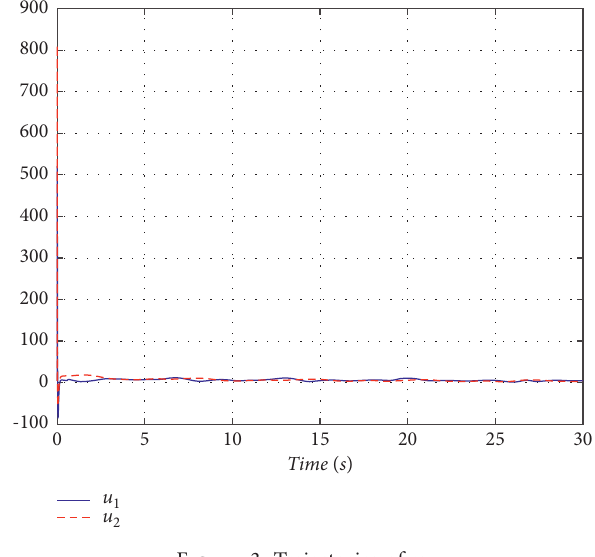
, x , x , and x 11 12 21